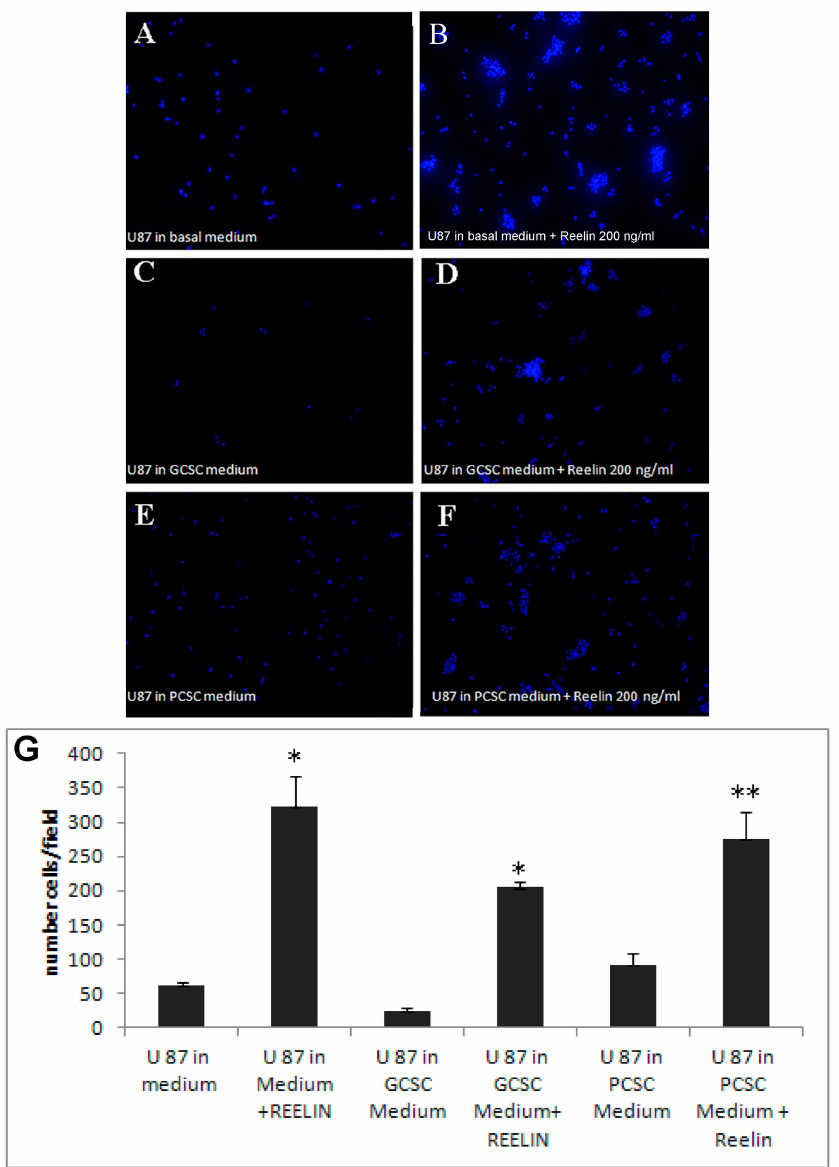
Figure 3. Effects of reelin and CSCs culture medium on U87MG migration. Cells were allowed to migrate for 18 h across the membrane in the Boyden chamber assay in the presence or absence of recombinant reelin. * p < 0.001 ** p < 0.05. ( A – F ), representative immunofluorescence images of migrated and DAPI-stained U87MG. ( G ), shows the average of migrated cells incubated with conditioned medium with or without 200 ng/mL recombinant reelin. Results are expressed as the number of cells/field; * p < 0.001 ** p < 0.05. Bars show the mean of migrated cells ± standard deviation from three